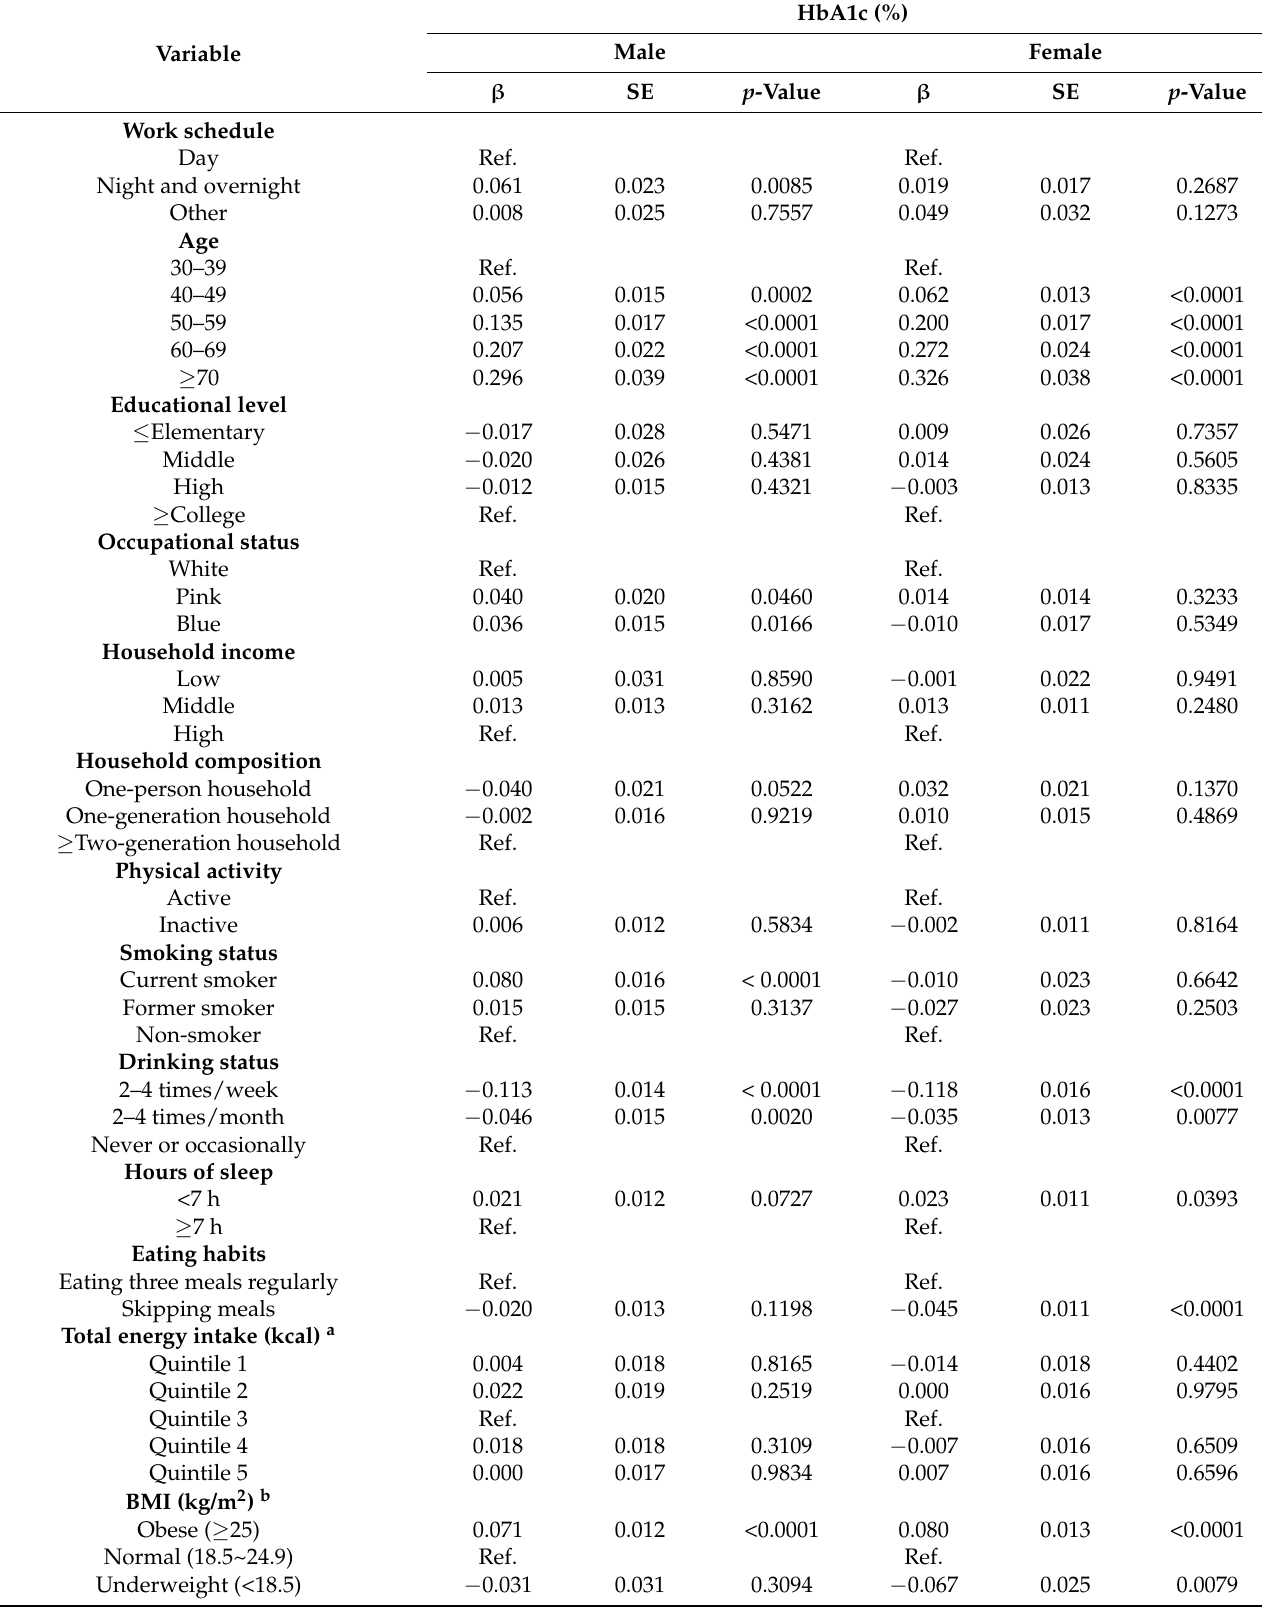
Table 2. Generalized multiple linear regression for HbA1c levels according to work